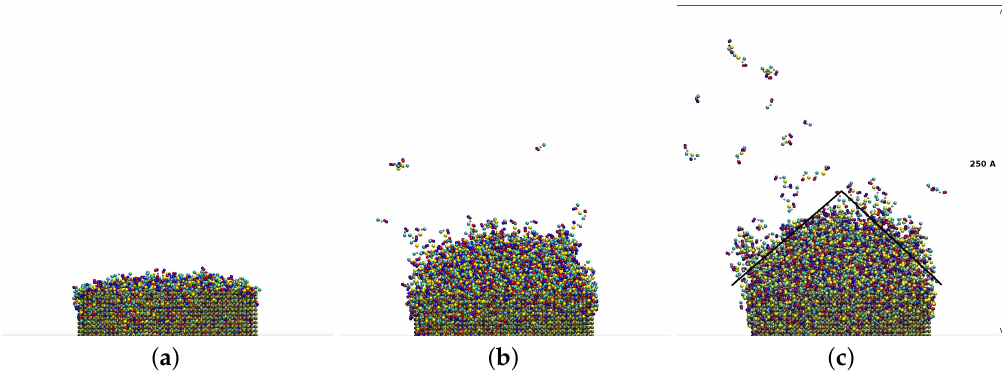
Figure 9. Snapshot of Taylor cone formation seen from coarse-grained MD simulation of EMIM-BF 4 . Mass flow rate and extraction potential of 1.22 × 10 − 12 kg/s and − 17 V, respectively. Atom colors are: M1 (teal), IM (silver), MR (red), M2 (navy), BF 4 (yellow) and Pt (bronze). The capillary diameter is 112 Å, and vertical dimensions are 250 Å. ( a ) At t = 400 ps; ( b ) At t = 500 ps; ( c ) At t = 600 ps.